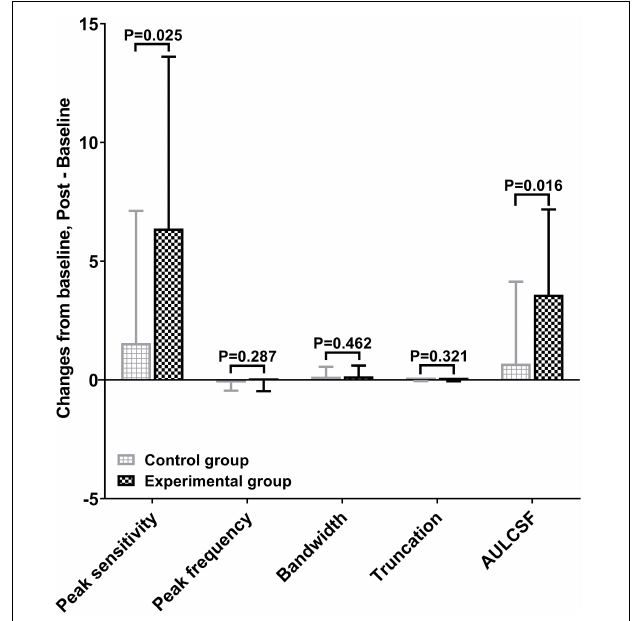
FIGURE 5 | Mean changes of post CSF parameters from baseline in control and experimental group.